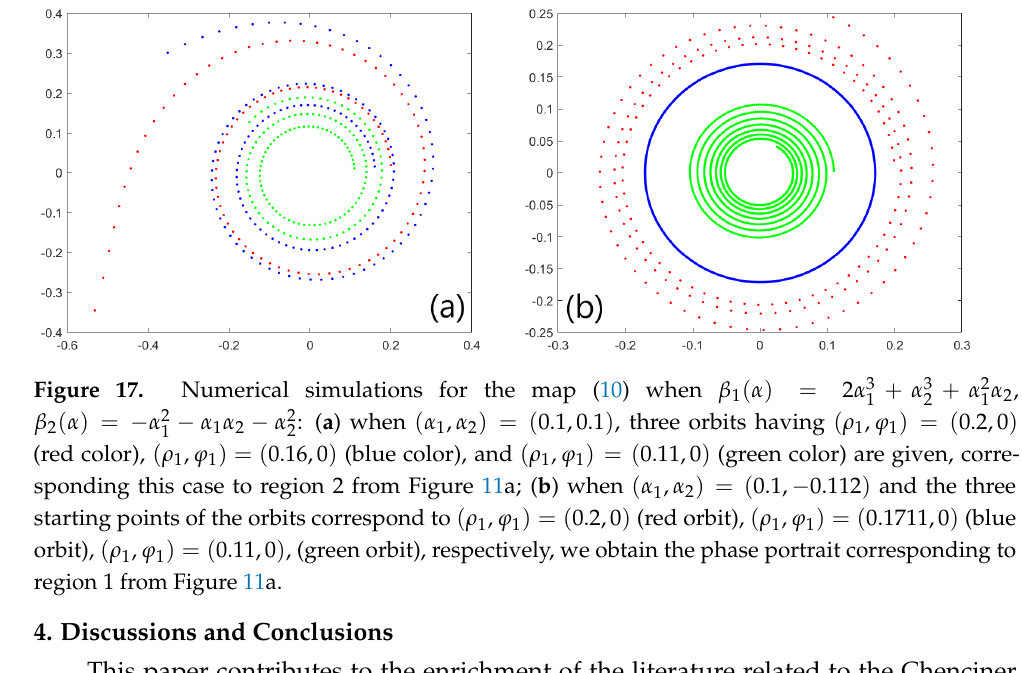
+ α 3 + α 2 α 2 , 2 1 1